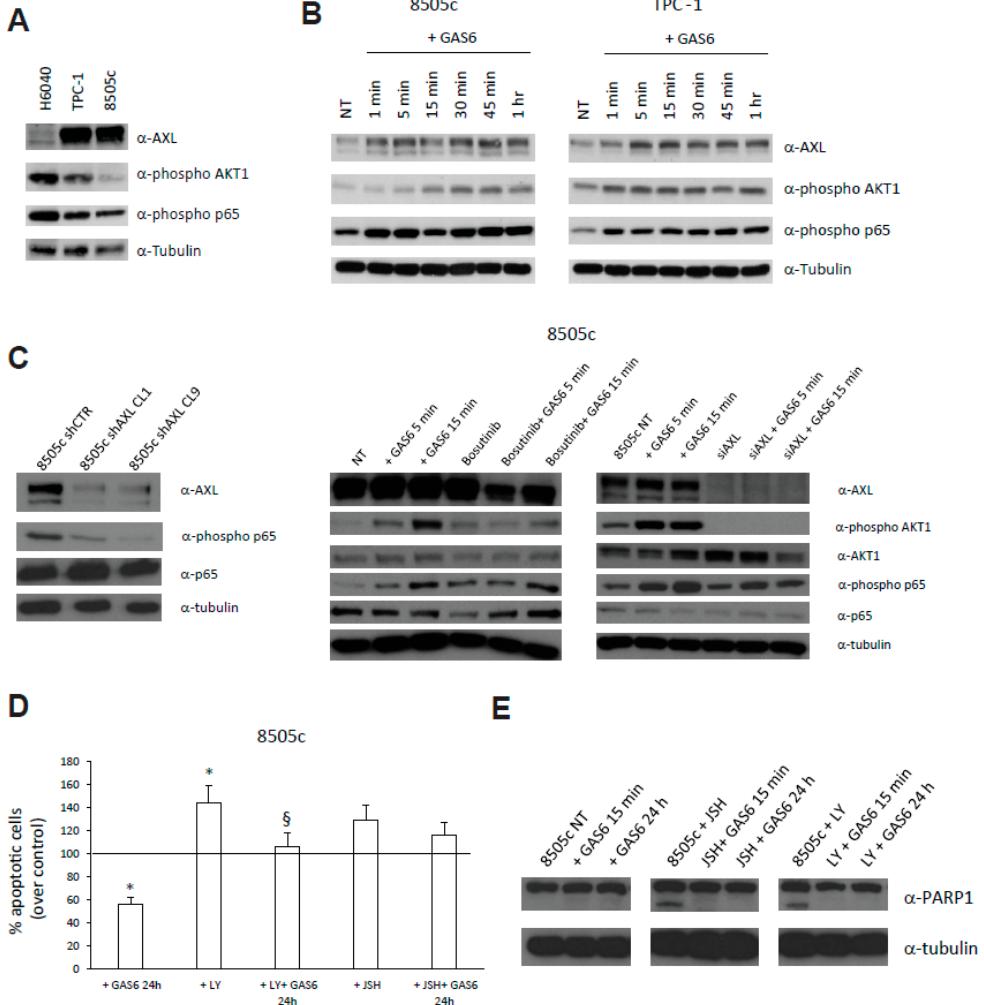
Figure 6. In vitro evaluation of AXL functions. ( A ) AXL, phospho-AKT1 and phospho-p65 levels evaluated in the indicated thyroid cell lines by Western Blot (WB) analysis. Anti-tubulin antibodies served as control for equal loading. ( B ) AXL, phospho-AKT1 and phospho-p65 levels in 8505c and TPC-1 cells treated with GAS6 (100 ng/mL) for the indicated time points, evaluated by WB analysis. ( C ) Levels of AXL, phospho-p65, and p65 in 8505c cell clones stably silenced for AXL (shAXL). Two clones are shown. AXL, phospho-AKT1, AKT1, phospho-p65, and p65 levels in 8505c cells treated or not with GAS6 (100 ng/mL) for the indicated time points in the presence or absence of Bosutinib (25 μ M) or siRNAs targeting AXL (siAXL). Anti-tubulin antibodies served as control for equal loading. ( D ) Percent relative to control of 8505c apoptotic cells, assessed by TUNEL assay, treated or not with